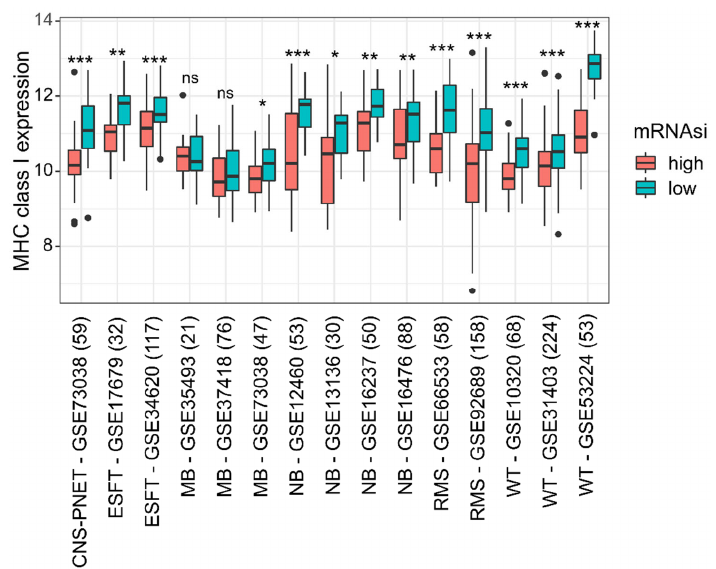
Figure 2. Low mRNAsi correlates with higher MHC class I gene expression levels in test and validation cohorts of pediatric small round blue cell tumors. Each GSE study was divided into a mRNAsi low (cyan) and mRNAsi high (red) group according to the median. The numbers of samples are given in parentheses. Two-sample t -test, * p < 0.05, ** p < 0.01, *** p < 0.001; not significant, ns. Abbreviations: Ewing’s sarcoma family of tumors, ESFT; medulloblastoma, MB; neuroblastoma, NB; central nervous system-primitive neuroectodermal tumor, CNS-PNET; rhabdomyosarcoma, RMS; Wilms tumor, WT.